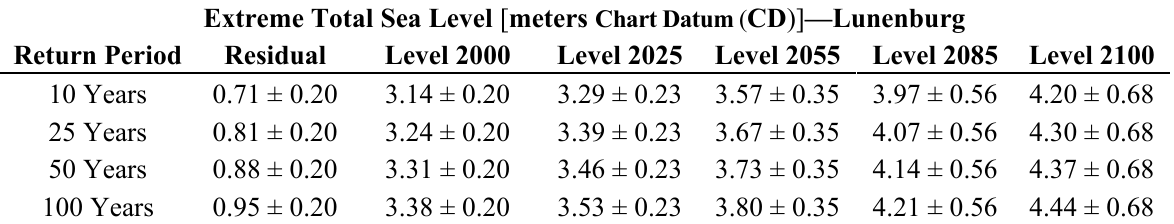
Table 1. Estimated extreme total sea levels (Higher High Water Large Tide (HHWLT) + Sea-Level Rise + Storm Surge) for return periods of 10, 25, 50 and 100 years for years 2000, 2025, 2050, 2085 and 2100. Lunenburg, HHWLT 2.43 m (Chart Datum), return period levels estimated as per Halifax tide gauge. From Richards and Daigle [45]. Error estimates are from [46] and represent 95% confidence